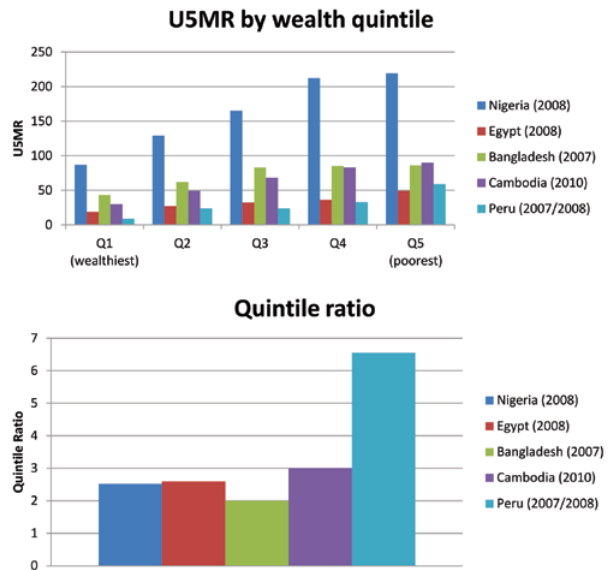
Figure 3 U5MR and inequity by wealth quintiles in exemplar countries.